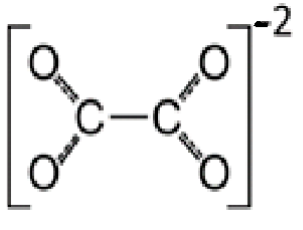
Figure 1. Chemical structure of oxalate anion